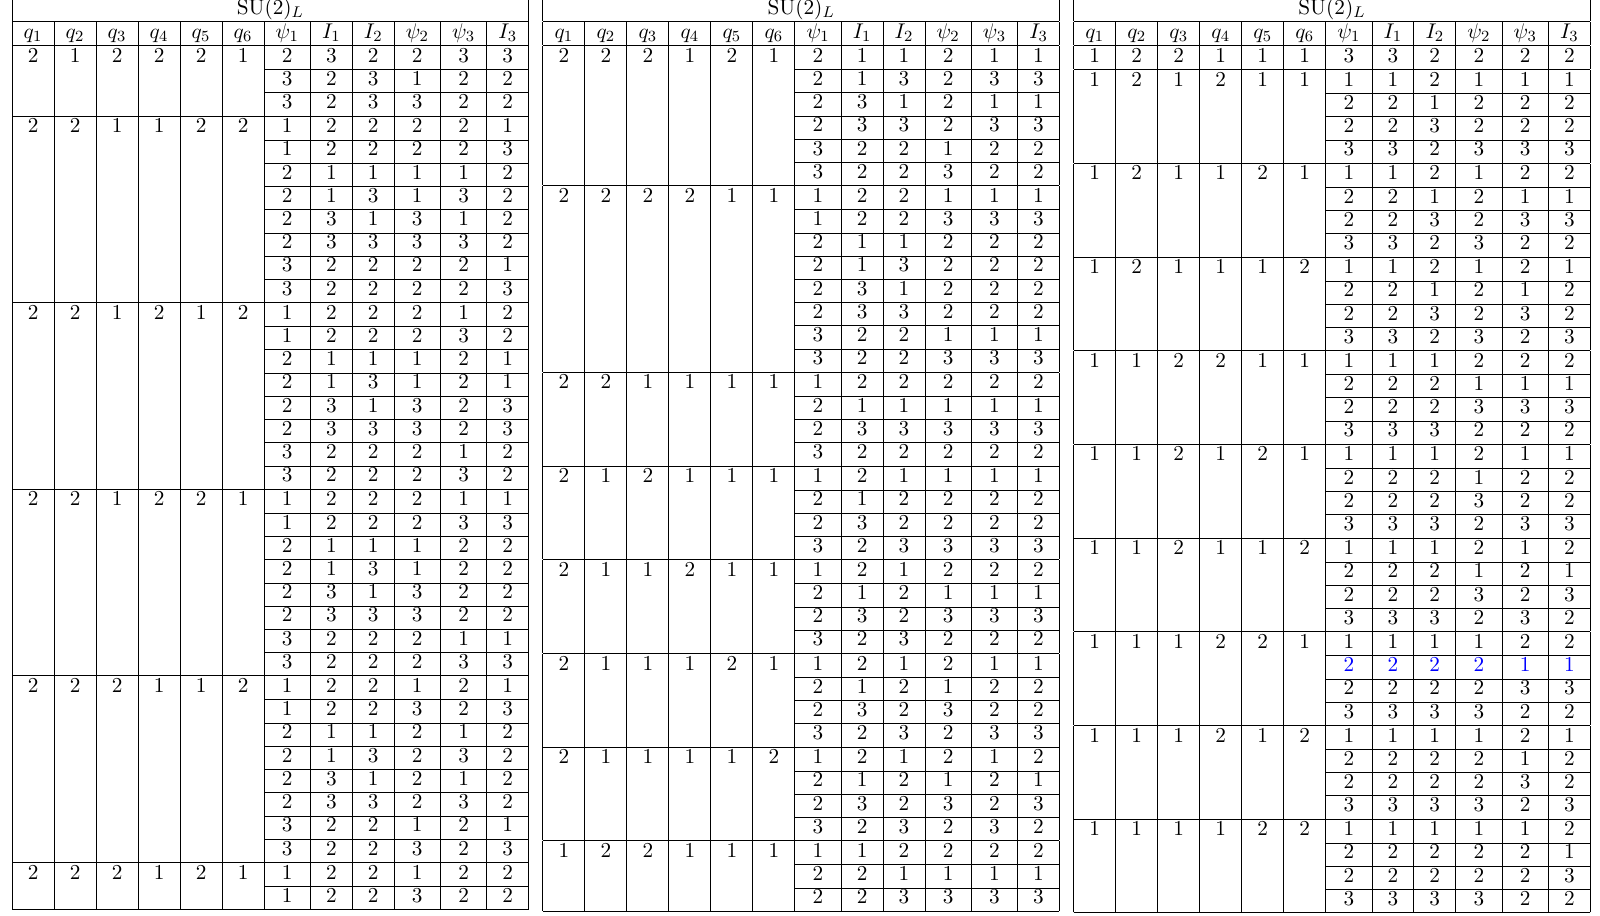
Table 12 . The possible SU(2) L numbers of the fields in Topology-L-8. The blue row is the one that we select in the example